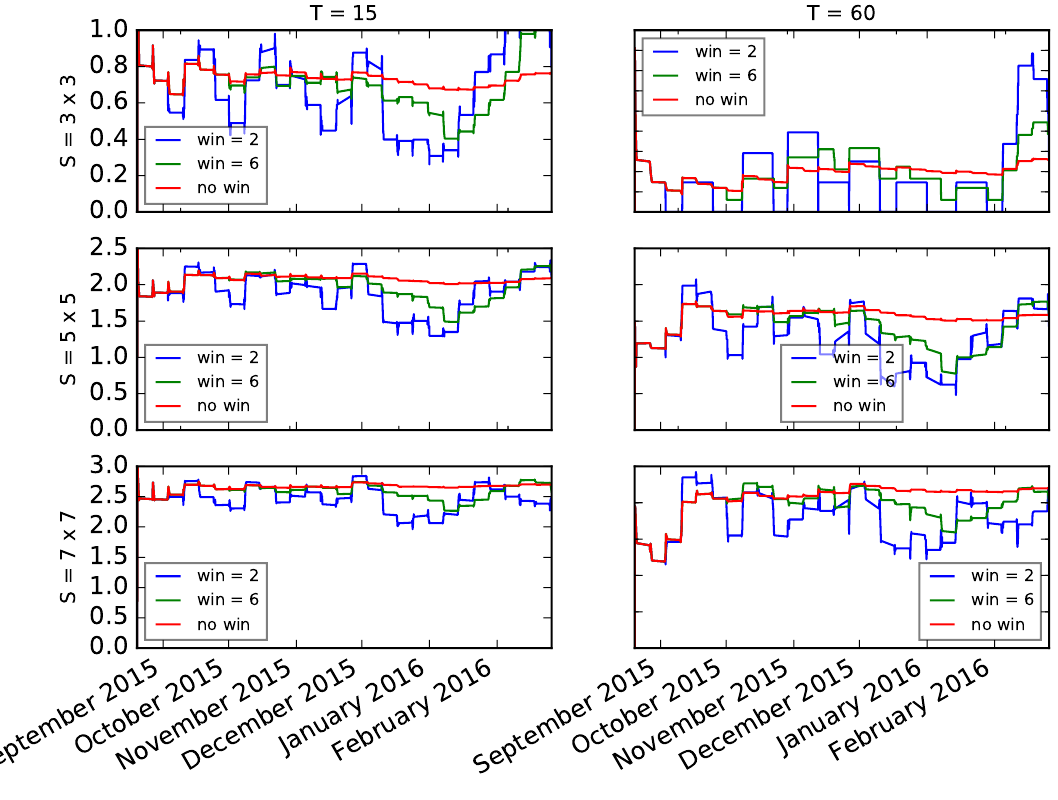
Figure 1. Entropy evolution of Thursdays for different values of time interval ( T min), grid resolution ( S ), and sequence window ( win weeks). Table 1. Special events